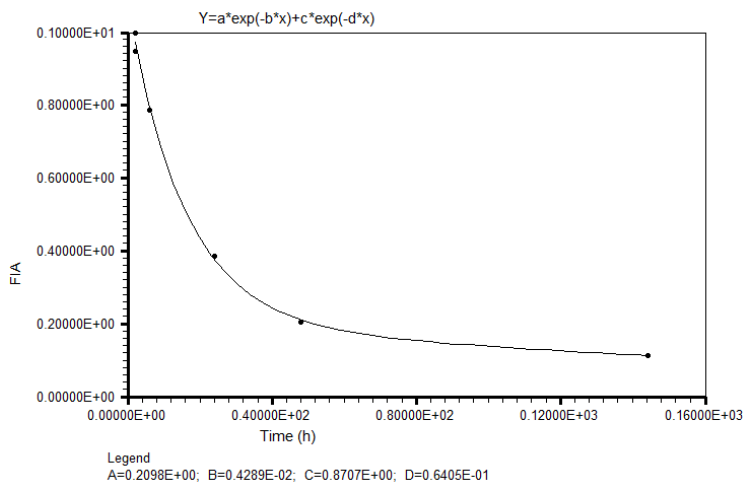
Figure 2. Bi-exponential fit of FIA WB values vs. time after administration.